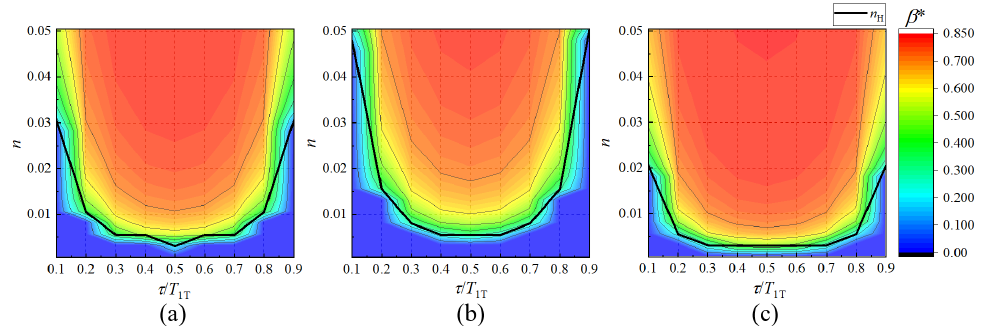
Figure 10. Contour of the pressure perturbation amplitude β ∗ for the limit cycle as functions of n and τ / T 1T for three flame length distributions: ( a ) convex distribution, ( b ) uniform distribution and ( c ) concave distribution. The thick lines correspond to marginal stable boarders or the lines of Hopf points.